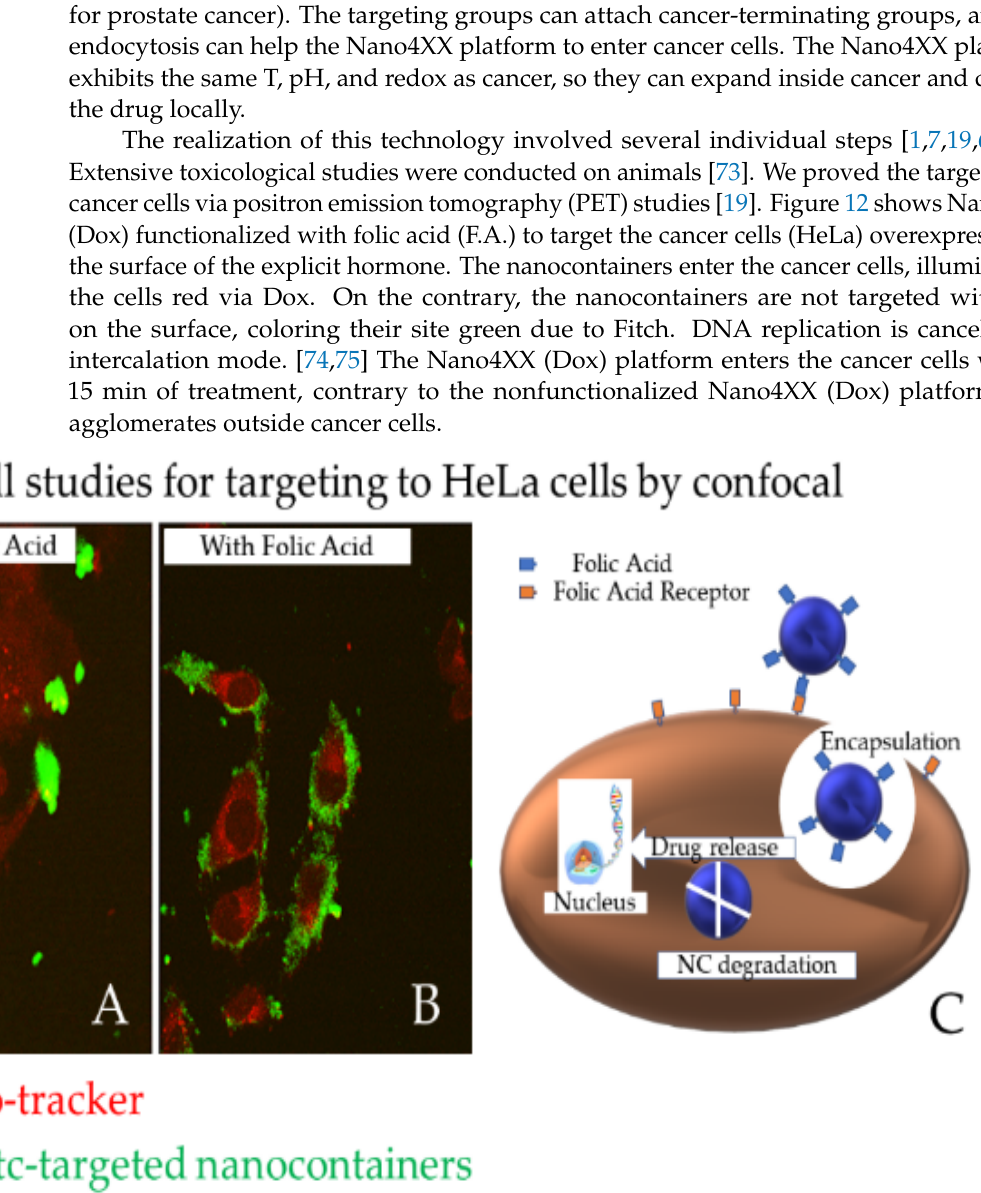
Figure 12. Cell studies for targeting HeLa cells by confocal microscopy [74,76]. ( A ) Agglomeration because the Nano4XX platform is not FA grafted (green color Nano4XX); ( B ) FA grafted Nano4XX color the cancer cell surface green, inside the cancer cells are colored red due to Doxorubicin; ( C ) FA-grafted Nano4Dox enter the cancer cell where they release Doxorubicin inside resulting in a destruction of cancer.